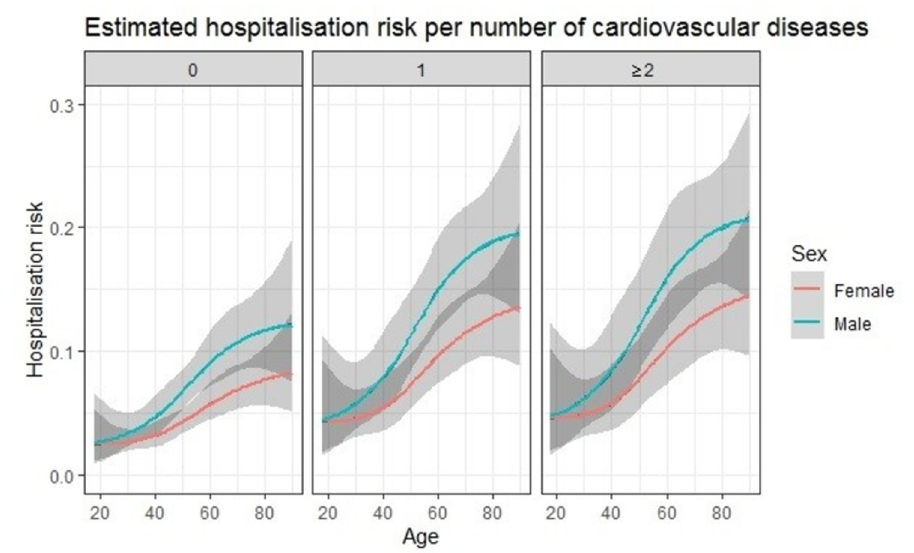
Fig 1. Predicted risk of hospitalisation. Plotted risk of hospital referral in (clinically suspected and confirmed) COVID-19 primary care patients at a certain age and stratified by sex and by the number of cardiovascular diseases and/or diabetes (i.e. 0, 1 or � 2). Confidence intervals are shown in grey.